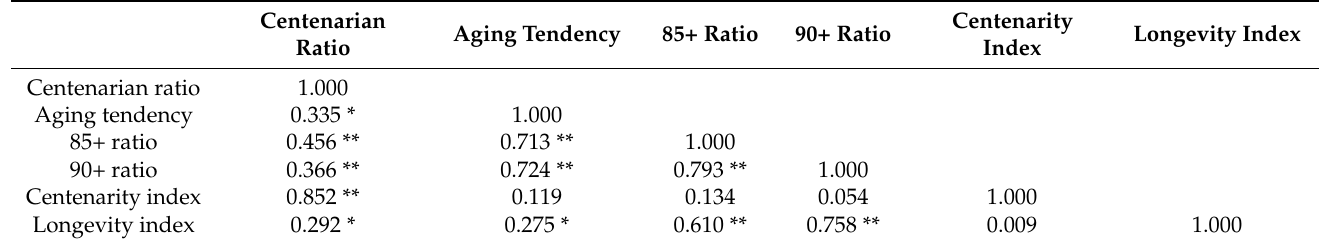
Table 6. Correlation analysis among the six longevity